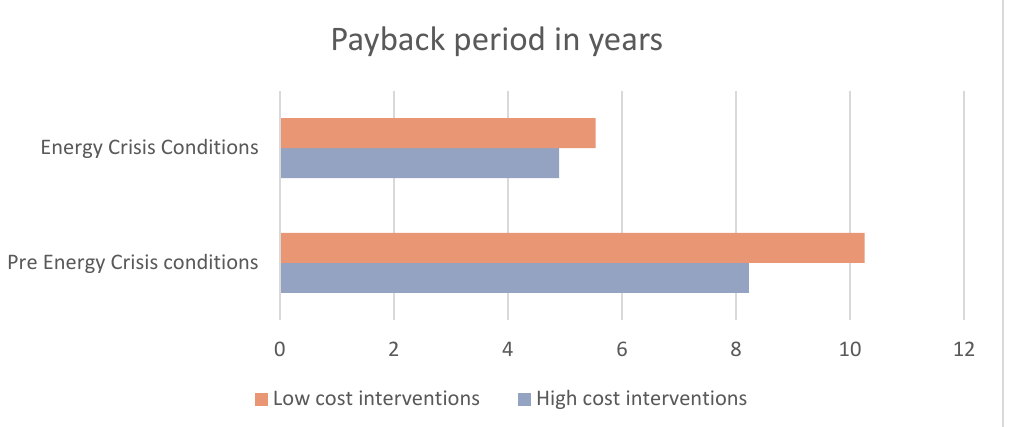
Figure 5. Payback period in years.